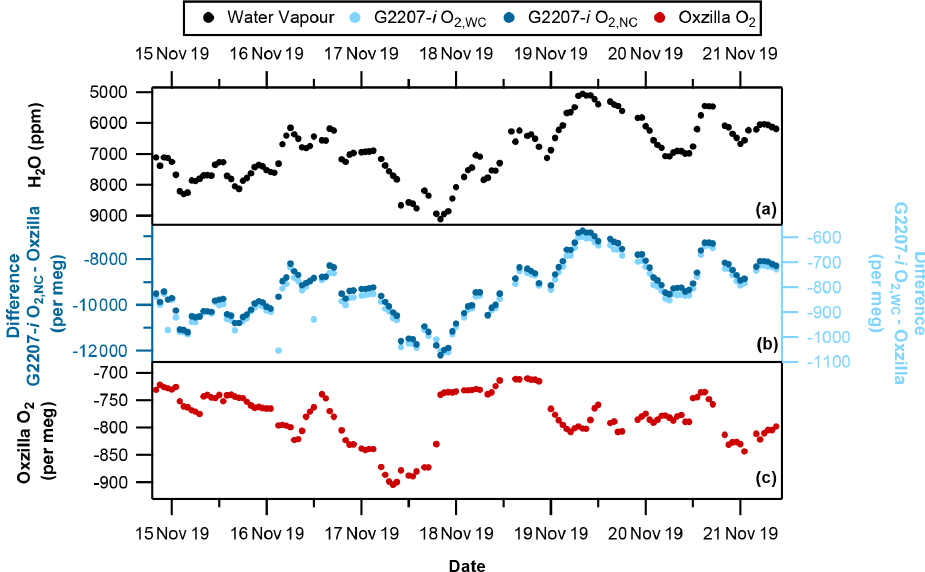
Figure 4. With no drying of the sample air through the G2207- i (a) hourly averaged water vapour, (b) G2207- i –Oxzilla difference for O 2 , NC (dark blue) and O 2 , WC (light blue), and (c) Oxzilla O 2 . Note the reversed water vapour axis and different axis scales for O 2 , NC and O 2 , WC .